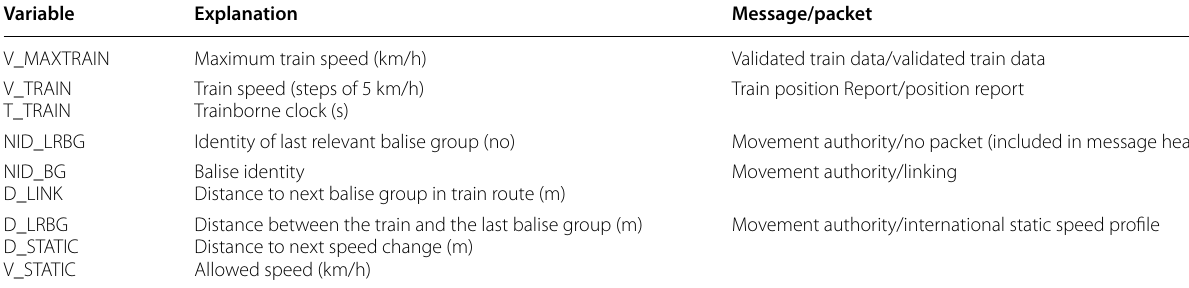
Table 2 Summary of variables of